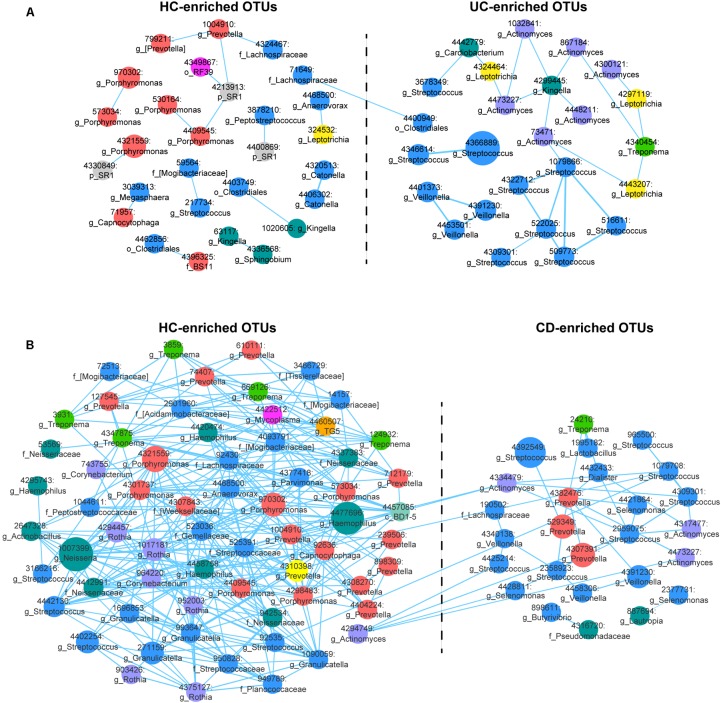
Correlation networks of differentially abundant Operational Taxonomic Units (OTUs) among the UC, CD and HC microbial communities. (A) The UC-associated network. Differentially abundant OTUs between the UC and HC groups based on the Wilcoxon rank-sum test were used for network construction. Pearson’s correlation coefficients among the centered log-ratio-transformed OTUs were calculated, and correlations with coefficients ≥ 0.4 and P-values < 0.05 were retained. In the network, each node represents an OTU. The node size is proportional to the mean relative abundance of the OTU. Lines between the nodes show positive correlations. (B) The CD-associated network.